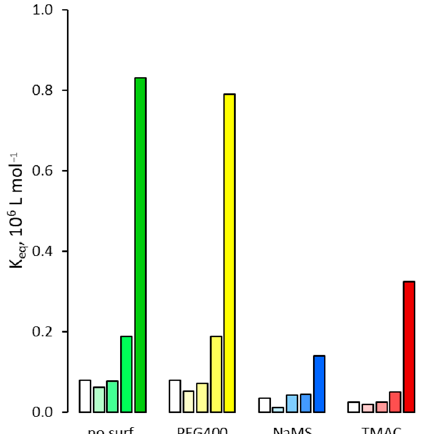
Figure 10. Binding affinity of 2,4,5-T for the MIP in presence of additives mimic of the polar part of the surfactants. For each group of bars from left to right: water molar fraction from 0 (pure acetonitrile) to 0.24, 0.42, 0.66 and 0.81.